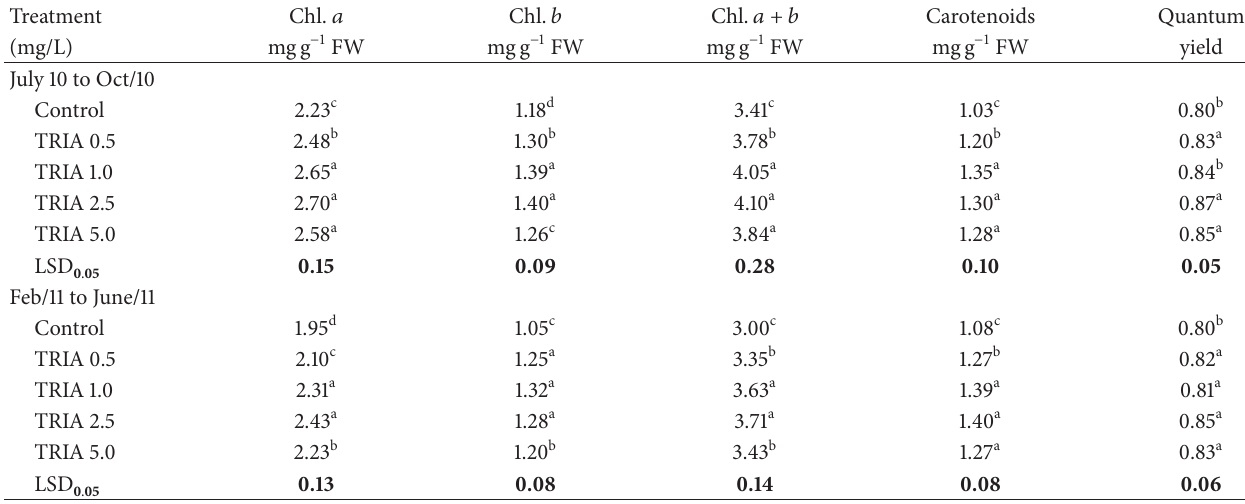
Table 3: The effects of TRIA on the photosynthetic pigments, carotenoids, and quantum yield of Bougainvillea glabra under natural conditions.